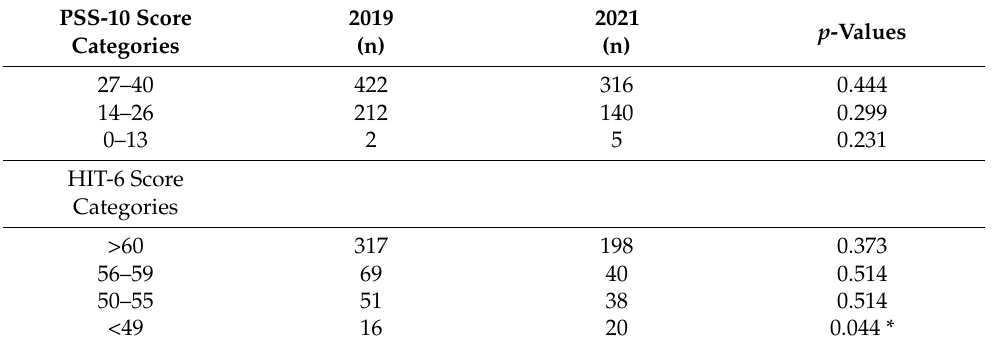
Table 4. Categorical values of the PSS-10 and HIT-6 scores when comparing the 2019 and 2021